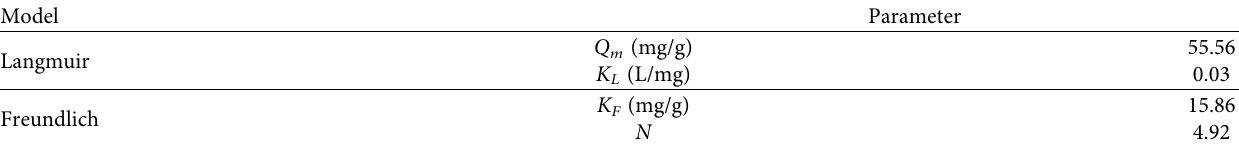
Table 4: Parameters of Langmuir and Freundlich isotherms for the adsorption of MB dye on the PVB/bentonite nanofbers. Model Parameter Langmuir